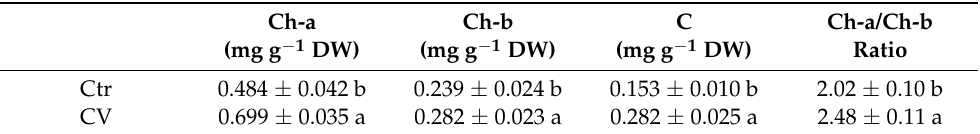
Chlorophyll and carotenoid contents in leaves of lettuce seedlings subjected to Chlorella vulgaris extract treatment (CV) after 21 days from the first treatment. Data are means ± SD. The values are the means of data from five replications. Values in the same column followed by differ- ent letters are significantly different ( p < 0.05). Ctr: control; Ch-a: chlorophylls a; Ch-b: chlorophylls b; C: total